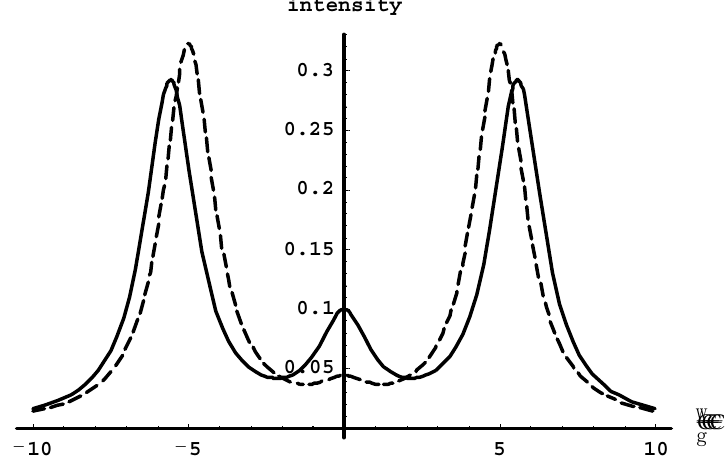
Figure 18. Comparison of the spectra of the Ly α line for the above example of tokamak EAST with the allowance for the spiraling trajectories of the perturbing electrons (solid line) and without this allowance (dotted line). The spectra were calculated for the observation at the angle of 20 degrees with respect to the magnetic field, which is the actual angle of the diagnostic window at EAST. For making the spectra universal, the frequency detuning ω was scaled to the characteristic frequency γ of some of the nonlinear processes in plasmas (details in [98]).